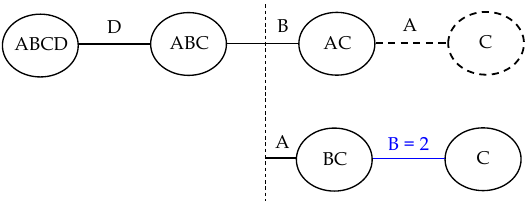
Figure A20. Tree graph for the analysis of the effect of factor C on the expected uncertainty performance. The dashed node and arc correspond to a rejected conclusion due to multimodal population. The arc in blue represents a decision on the value of factor B based on a forced interaction.